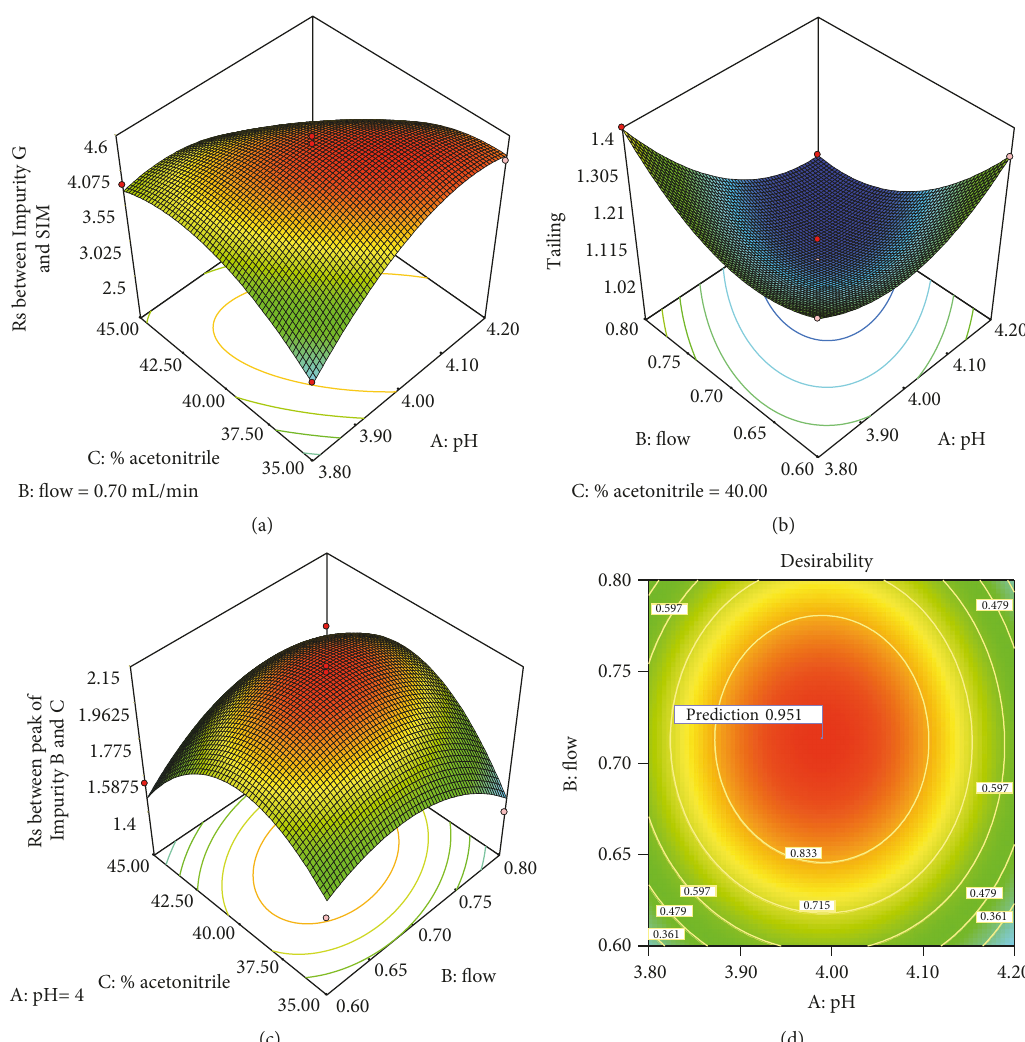
Figure 2: 3D surface plot representing the (a) Rs between impurity G and SIM, (b) tailing factor, and (c) Rs between peaks of impurities B and C, as a function of % organic modifier, pH, and flow rate. (d) Desirability plot for optimization of the selected responses where the red area corresponds to the optimum chromatographic conditions while ACN content maintained constant at 40%. Color change from blue to red represents increasing response values (min